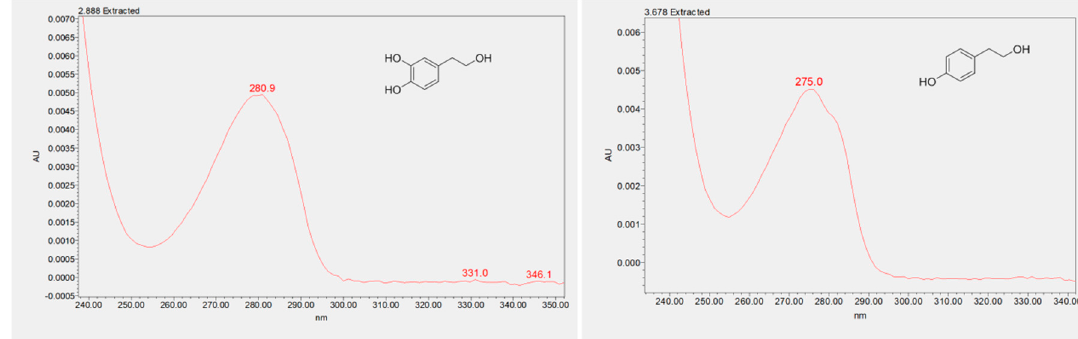
Figure 4. HTyr and Tyr UV-visible spectra.